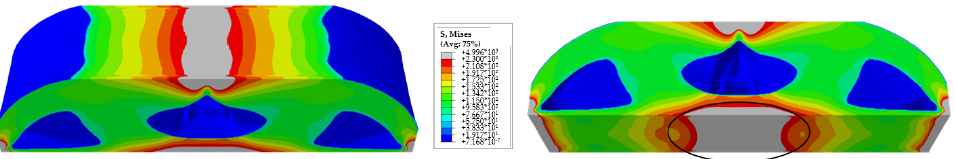
Figure 18. Results of the static FE analysis for the derived design proposal of the developed optimiza- tion method under the boundary conditions of optimization case 1.